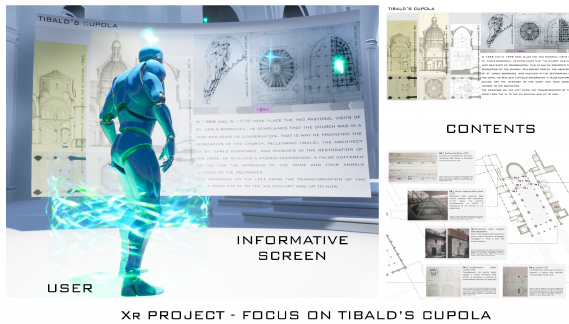
Figure 12. The Xr contents related to the focus of the double- waved curve wall: different data sources have been used for a detailed 3D mapping in Unreal Engine 4.